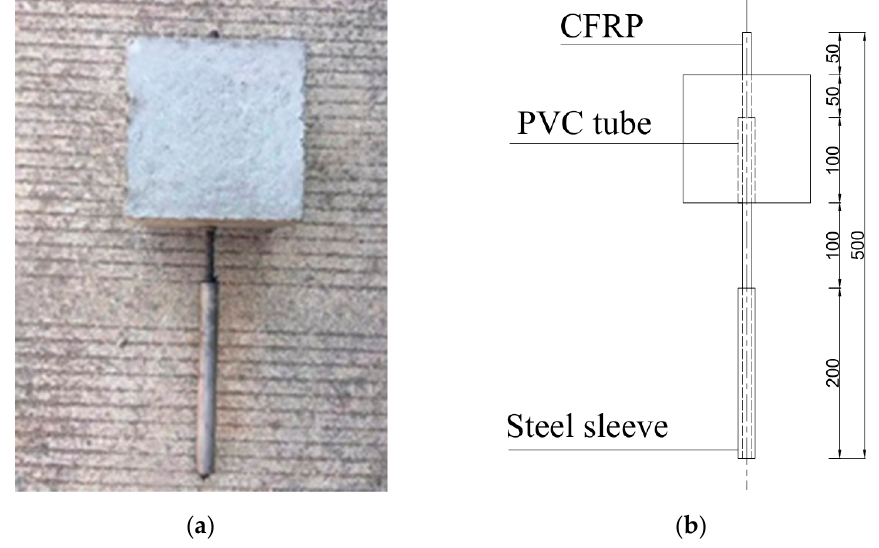
Figure 3. Pull-out specimen: ( a ) photograph; ( b ) illustration.